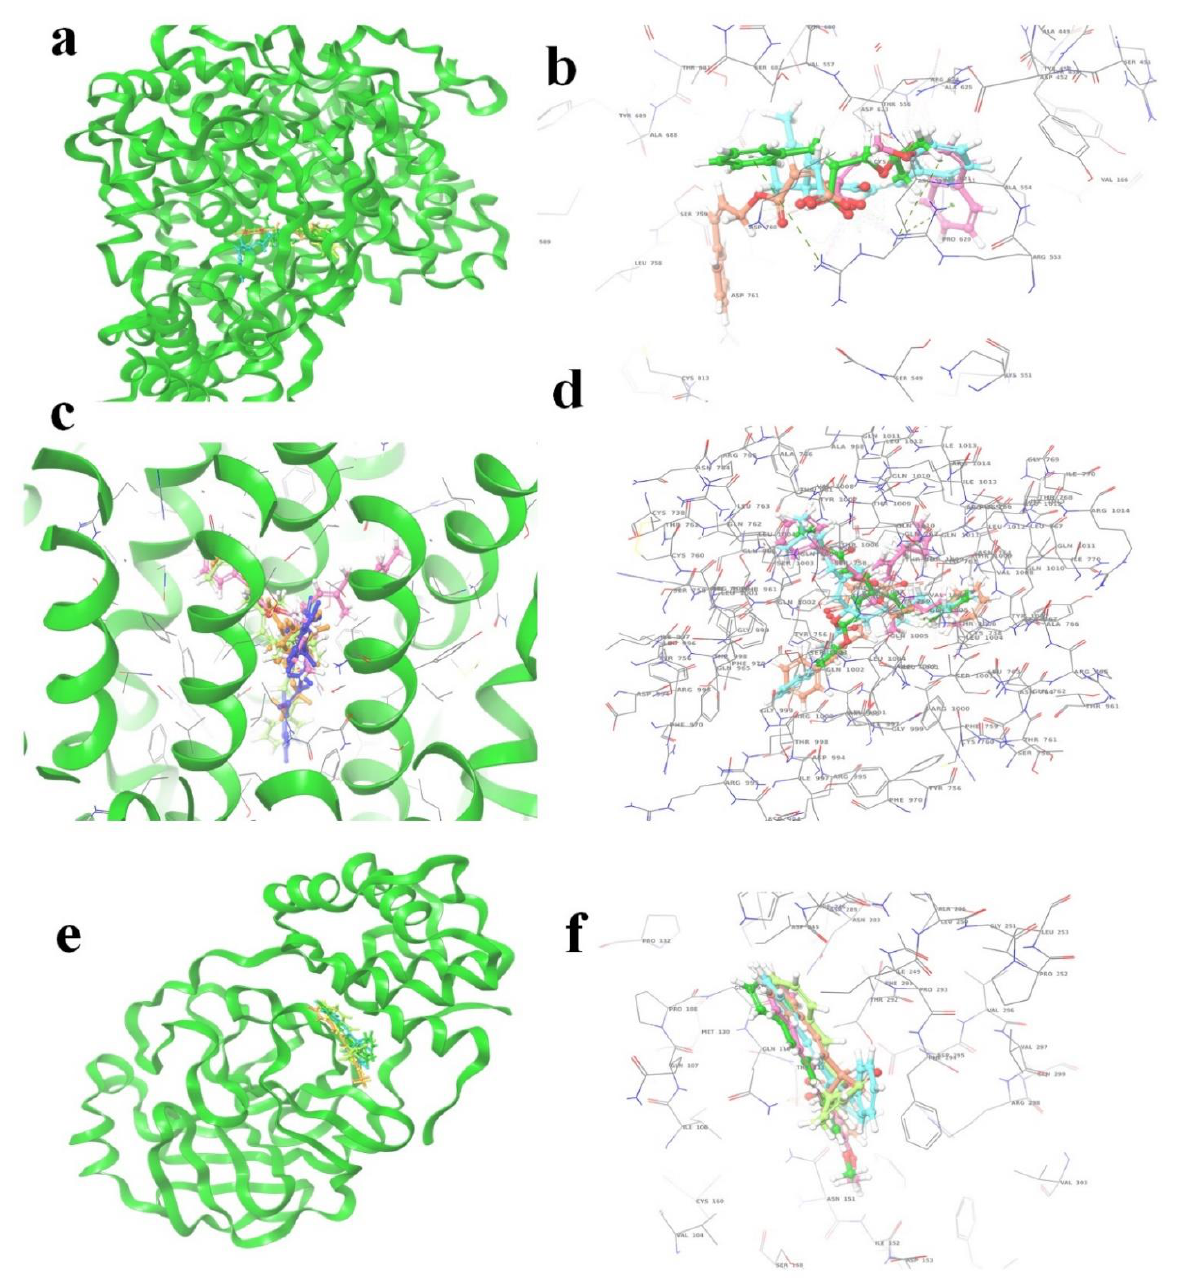
Figure 5. The 5 highest-ranked compounds shown in the docked position of target proteins, which occupies one pocket, and the three-dimensional structure is represented as ( a , b ) RDRP (R series), ( c , d ) spike glycoprotein (S series), and ( e , f ) main protease (M series). The ligand molecules are represented by the following colors: yellow (R1, S1, M1), orange (R2, S2, M2), sky blue (R3, S3, M3), magenta (R4, S4, M4), and purple (R5, S5, M5).